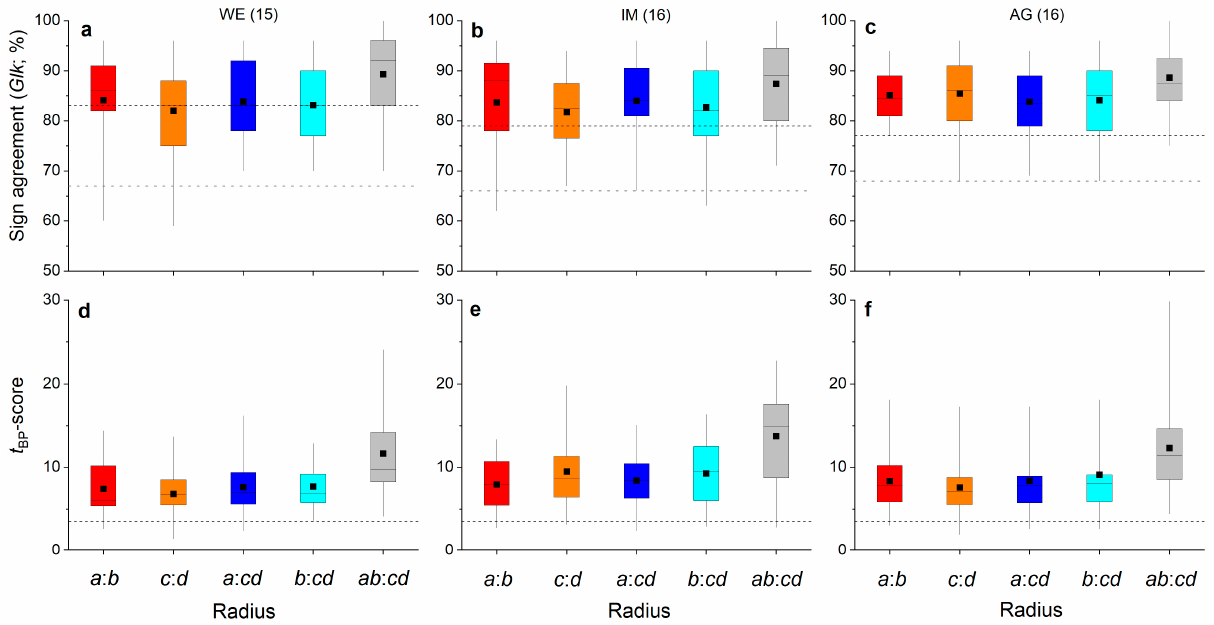
Figure 4. Box-plots showing variability in percentage of sign agreement (( a – c ); Glk = Gleichläufigkeit; Eckstein and Bauch 1973) and the t BP -score (( d – f ); Baillie and Pilcher 1990) among opposite radii (i.e., a : b and c : d ), radii taken at the lower and upper side of the stem to the mean of radii measured perpendicular to these radii (i.e., a : cd and b : cd , respectively) and mean of radii a and b vs. mean of radii c and d (i.e., ab : cd ) of all shoots taken from one stock at a wind-exposed ridge (site WE), an intermediate site (IM) and a north-facing avalanche gully (site AG). Number of shoots meas- ured per stock are given in brackets. In ( a – c ), horizontal dashed black and grey lines indicate the signi fi cance level of p ≤ 0.001 and p ≤ 0.05, respectively. In ( d – f ), the horizontal dashed black line indicates a t -value of 3.5 (see Material and Methods for details). For details on box-plots, see Figure 2.